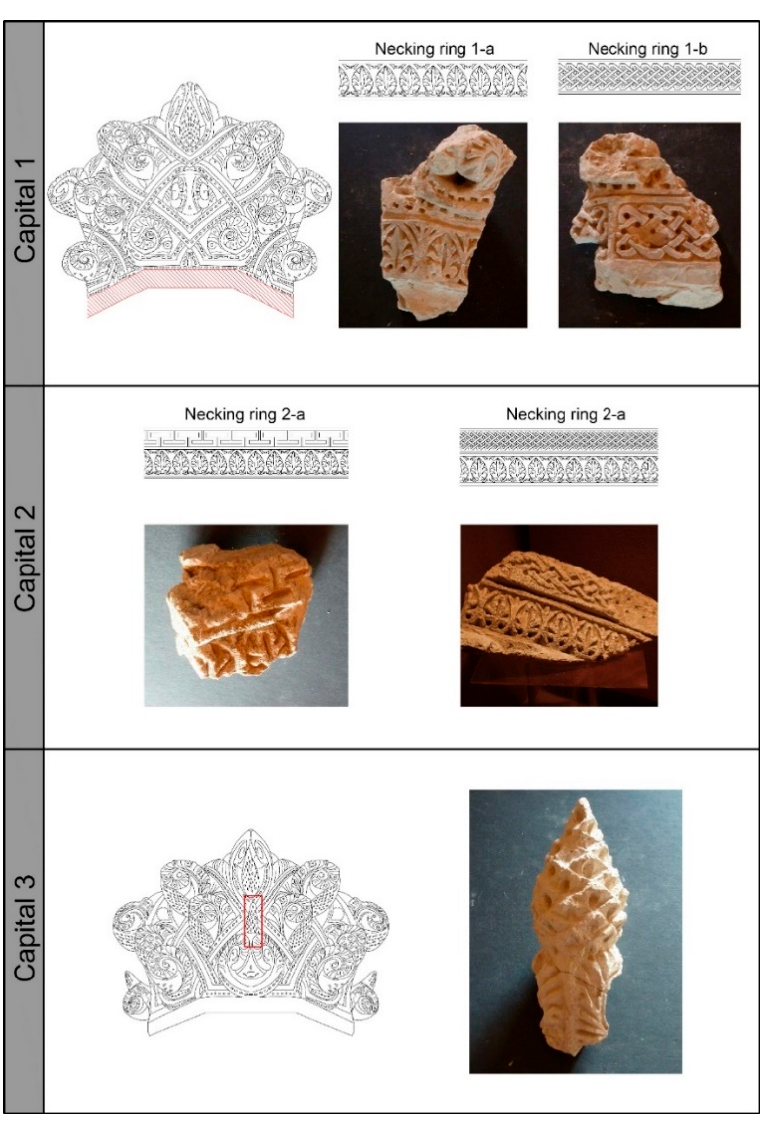
Figure 8. Fragments and possible reconstruction of the capitals of Molina de Aragón Synagogue. Created by author.